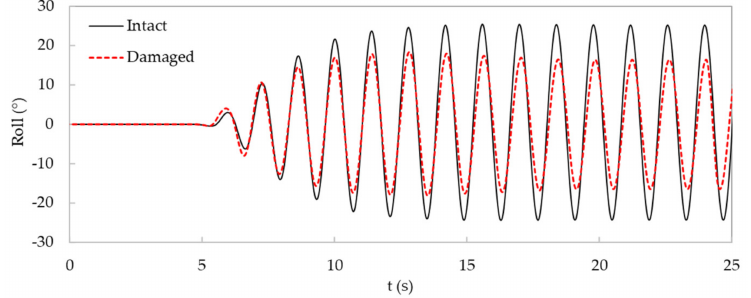
Figure 14. Time histories of ship motion in the numerical simulations.